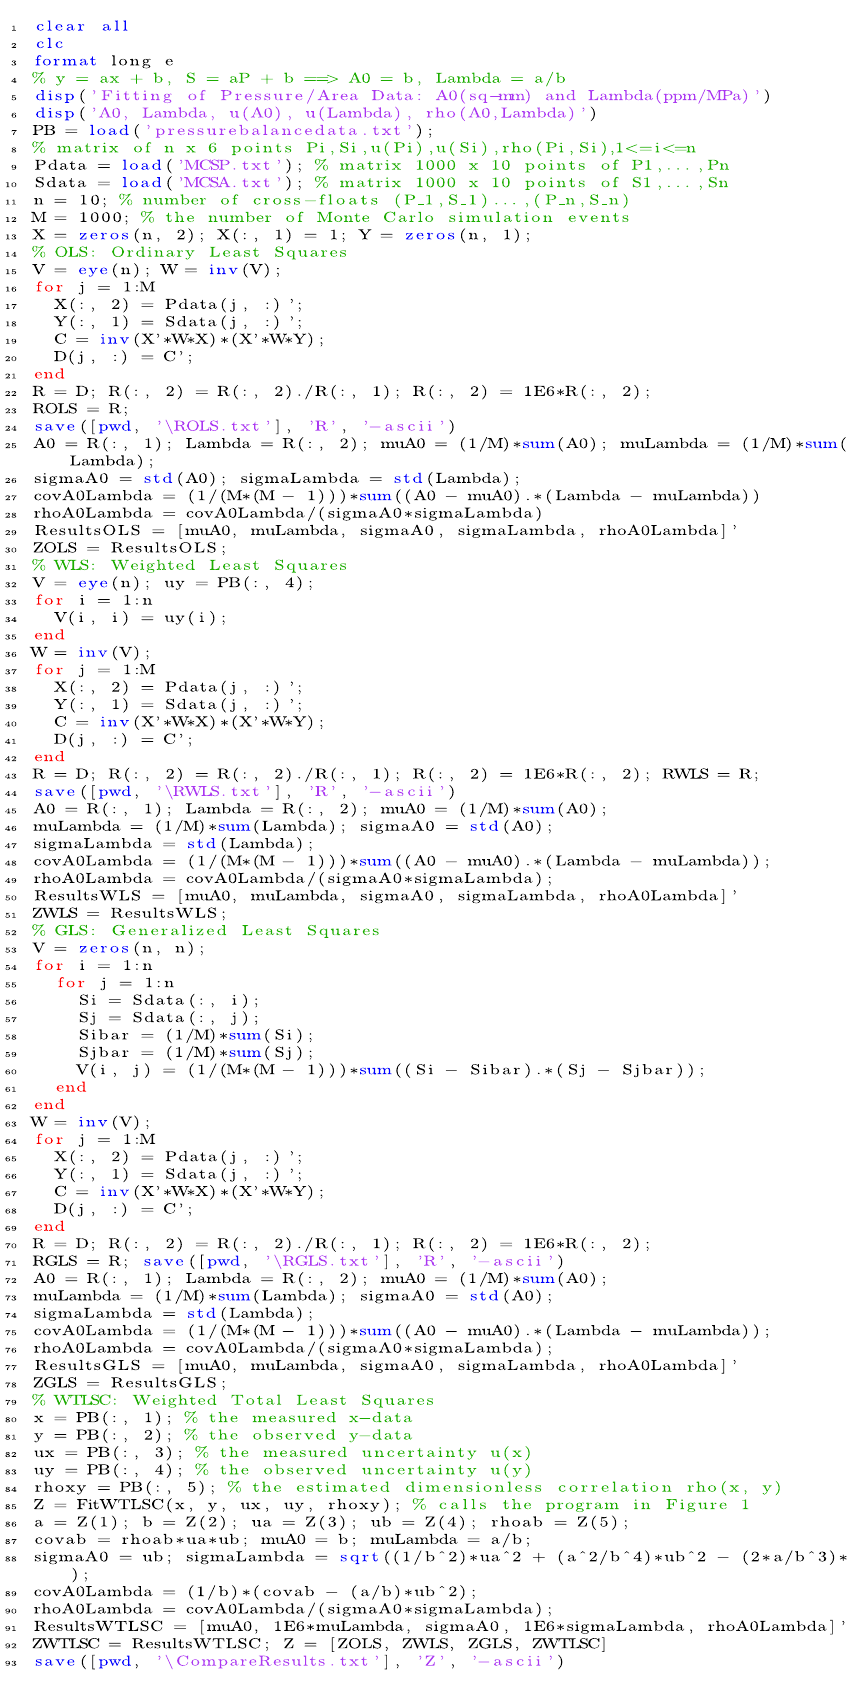
Fig. B1. Gnu Octave/Matlab function fi le to implement OLS, WLS and GLS regression